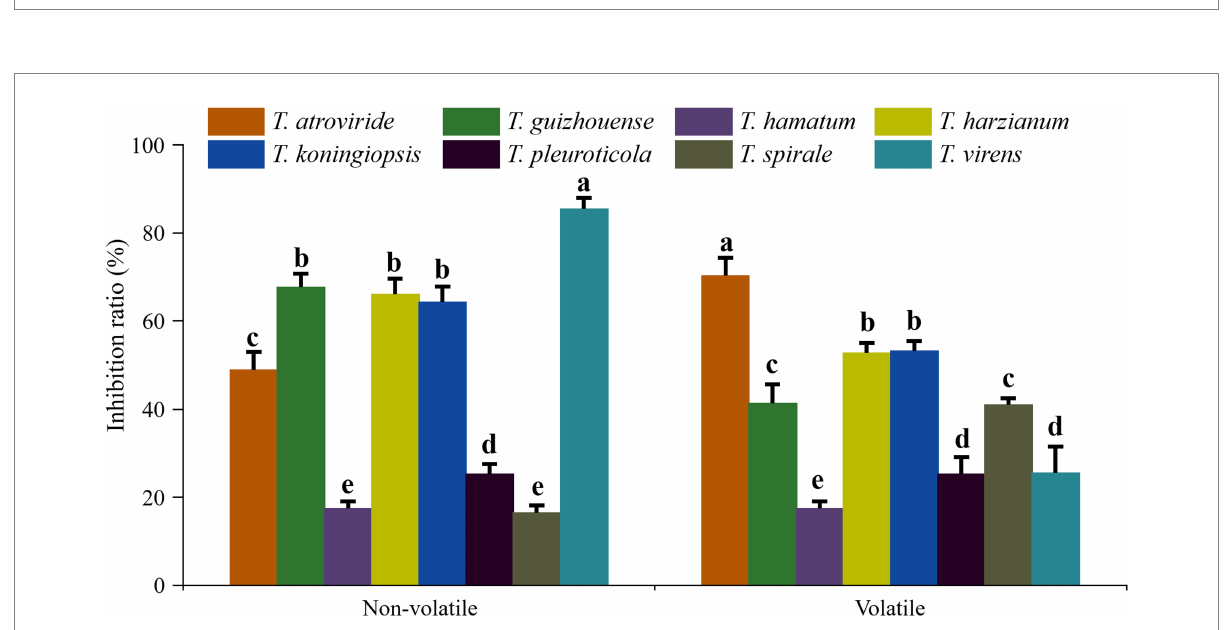
FIGURE 7 Inhibition rates of different Trichoderma species on the mycelial growth of Ganoderma lucidum . Data represent the mean of two independent replicates with five plates each. Significant differences ( p < 0.05) between means are indicated using different